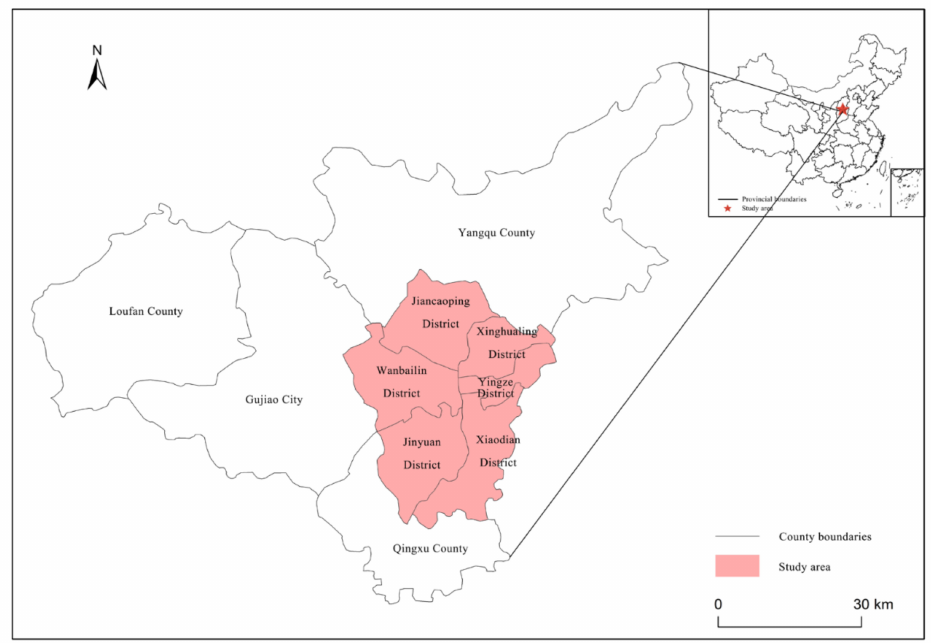
Figure 1. Location of Taiyuan Municipal